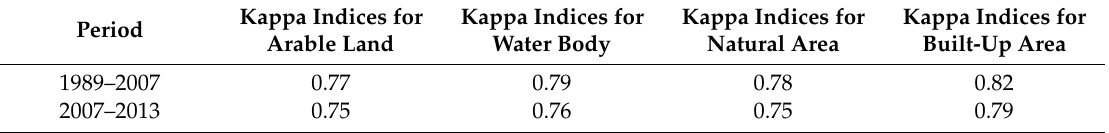
Table 9. Kappa statistics for the assessment of modeling simulation results in the NXEZ. Kappa Indices for Kappa Indices for Kappa Indices for Kappa Indices for Period Arable Land Water Body Natural Area Built-Up